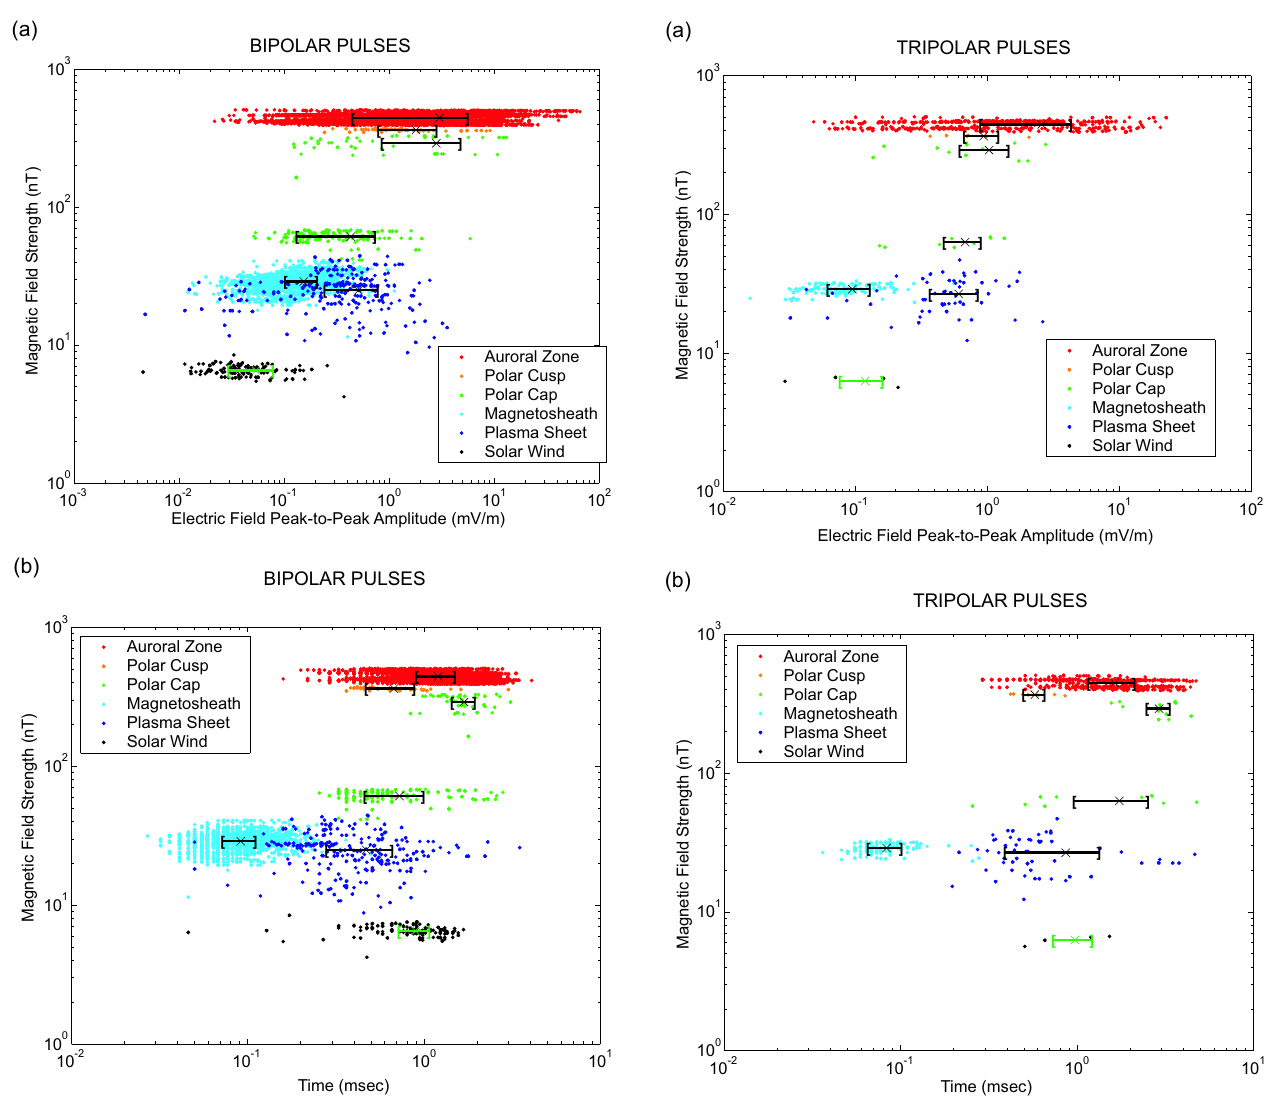
Fig. 4. Survey of the tripolar pulses observed by Cluster WBD over a two-year period. ( a ) Electric field amplitude vs. magnetic field strength showing a trend of increasing electric field amplitude with increasing magnetic field strength, just as for the bipolar pulses. ( b ) Pulse duration vs. magnetic field strength showing no trend between the two, but pointing out the obvious difference of the time durations of the magnetosheath pulses to pulses in all other regions, just as for the bipolar pulses. pulses are also labeled as “clipped” if the instantaneous dy-